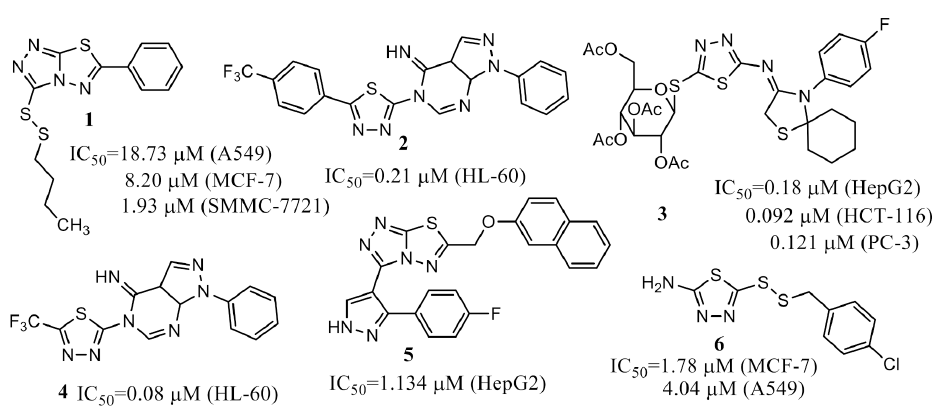
Figure 1. Anti-tumor active compounds with 1,3,4-thiadiazole core